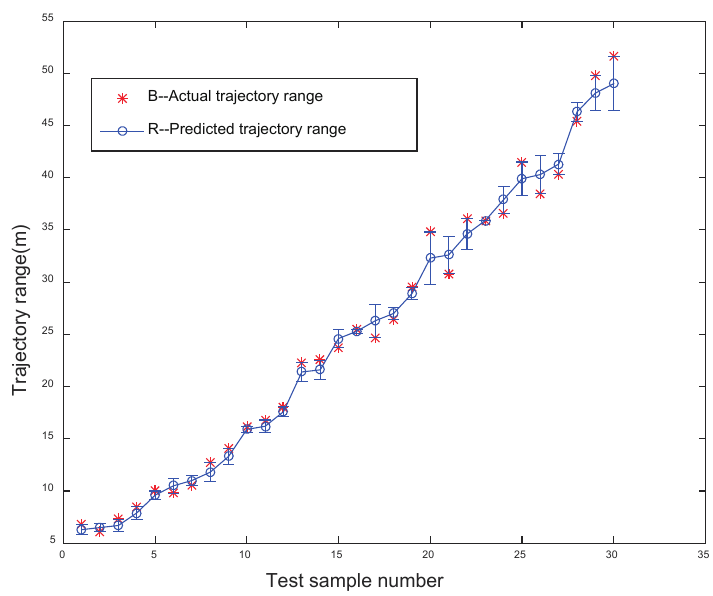
Figure 11. Residual graph of the multiple regression models (red and blue dots represent the predicted and actual values of the trajectory range,